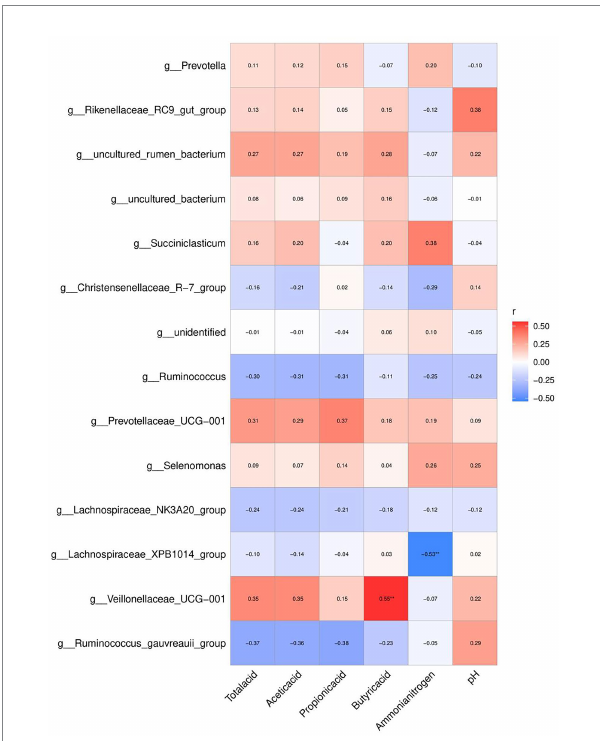
FIGURE 6 Effects of the diets on correlation between the top 20 relative abundances of genera, rumen VFA and enzyme activity mpositional profifiles of Hu sheep. * p < 0.05; ** p <